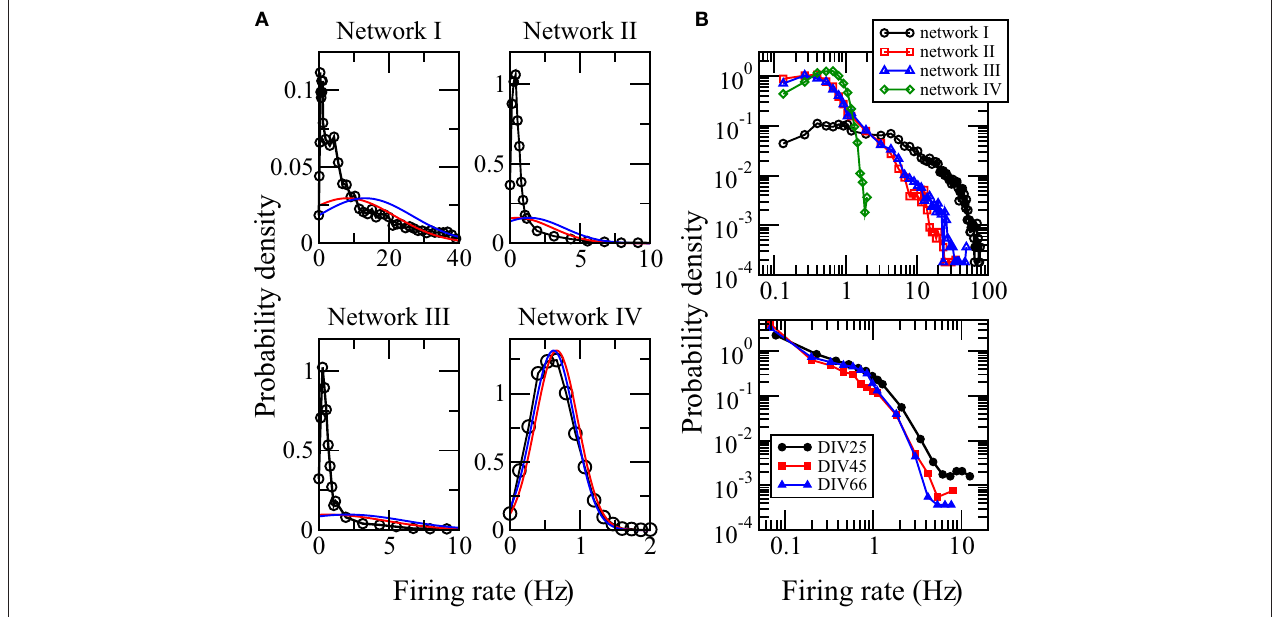
FIGURE 2 | Distributions of firing rates. (A) Distributions calculated from the simulation data for networks I–IV. The red curve is a Gaussian distribution with the same median and standard deviation while the blue curve is a Gaussian distribution with the same mean and standard deviation. (B) Comparison of the distributions of firing rates for networks I–IV (upper panel) with those calculated using the spikes detected in the measured MEA recordings DIV25, DIV45, and DIV66 (bottom panel) from which networks I–III were reconstructed. The data points for zero firing rate are removed. A good resemblance of the long tails in the distributions for networks I–III can be seen.